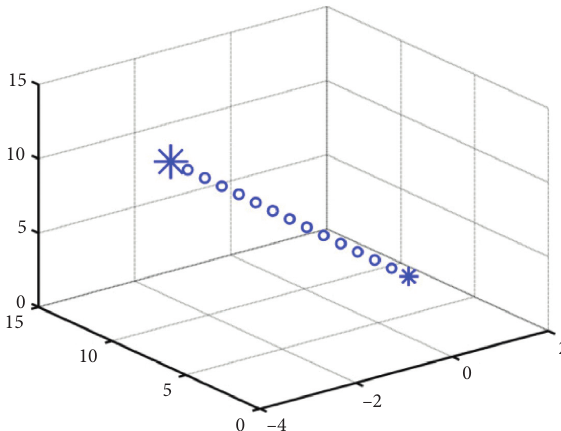
Figure 12: State trajectory of the leader for the leader-following